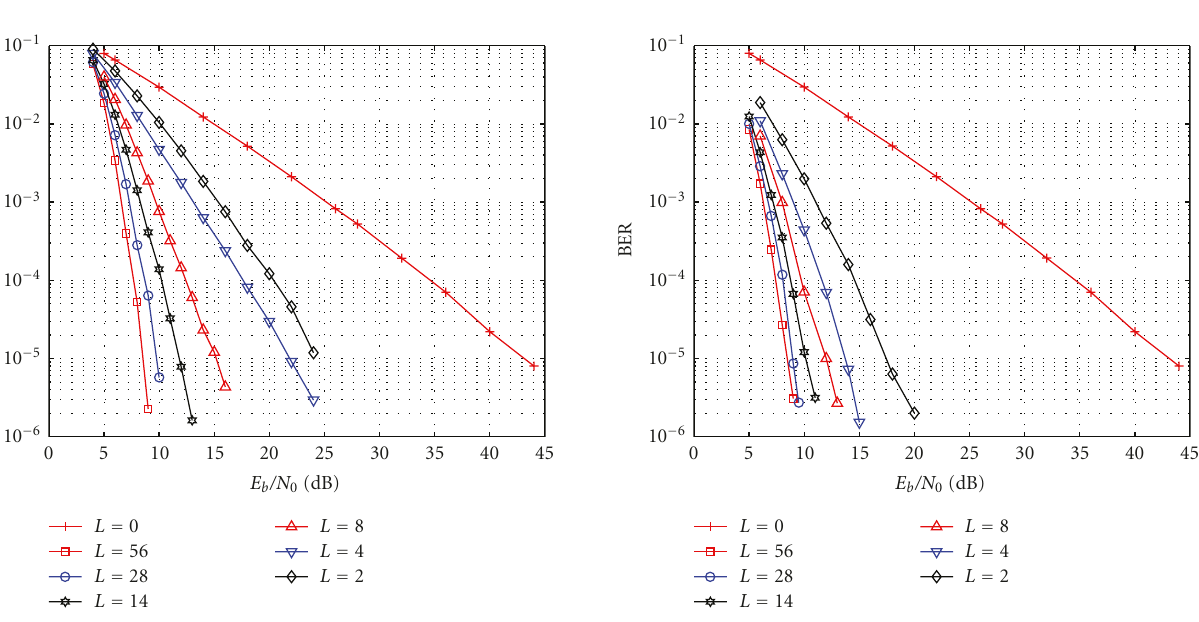
Figure 7: Performance of distributed GLD codes with source- destination path.